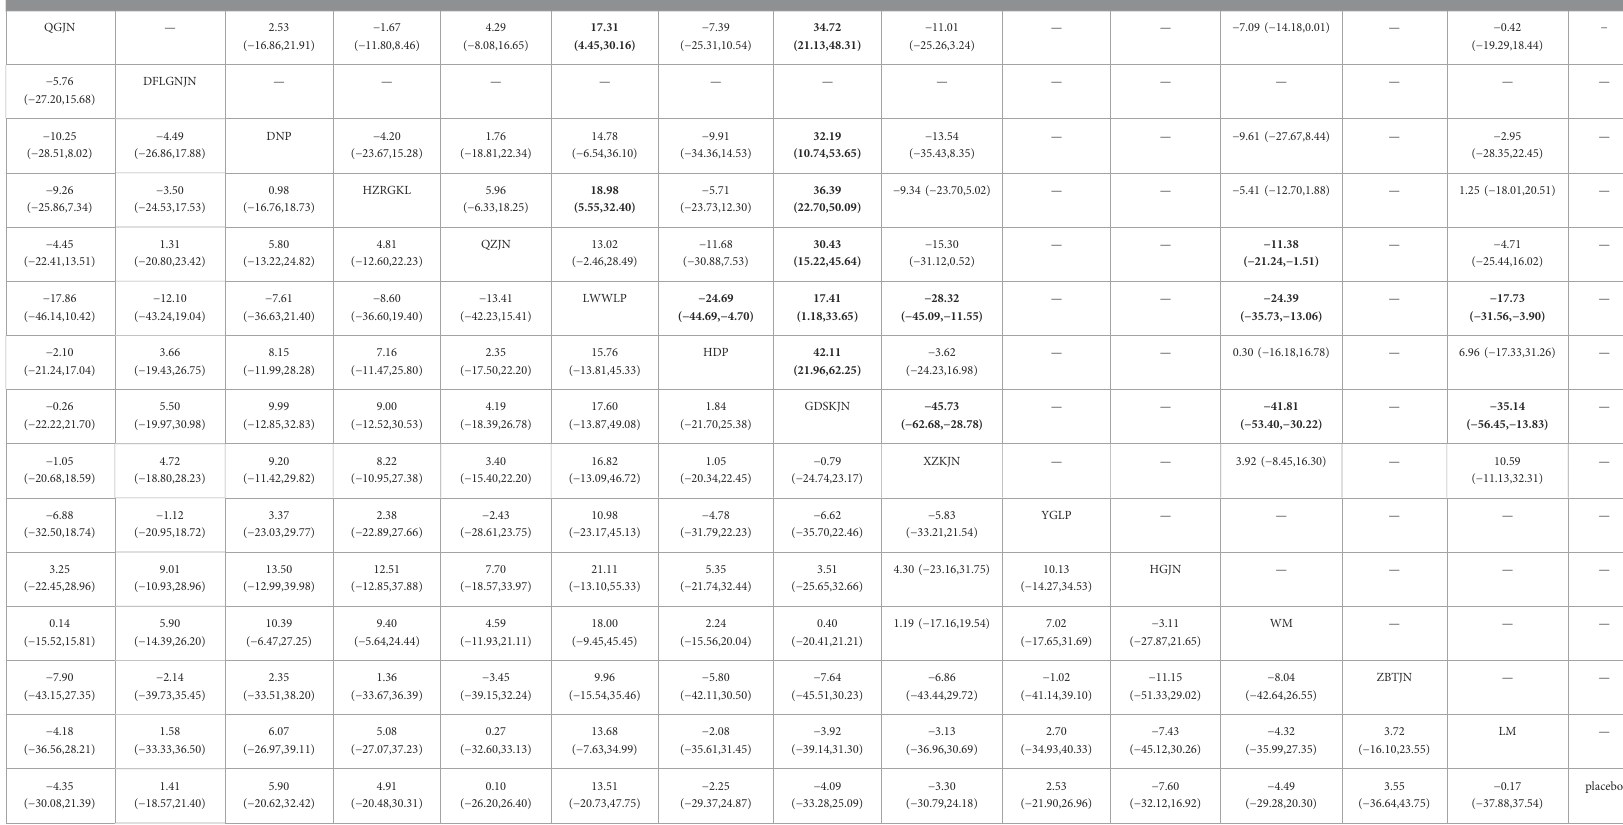
TABLE 3 The league table of AST and GGT. Comparisons for AST (bottom left) and GGT (upper right) of CPMs QGJN